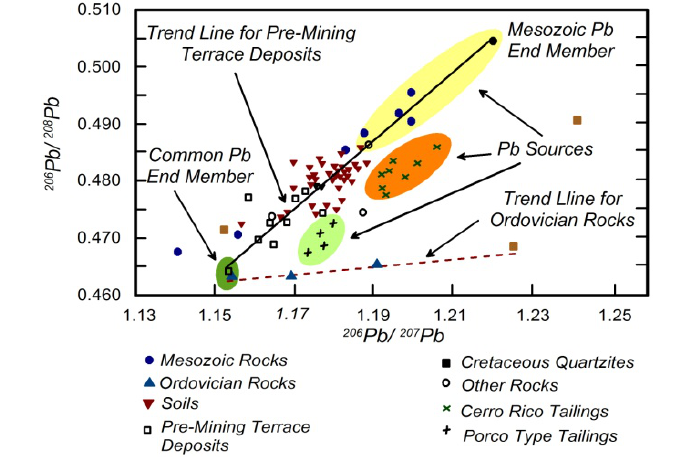
Figure 11. Soil samples from floodplain agricultural fields collected along the Rio Pilcomayo, Bolivia, exhibit Pb isotopic values that fall within the range established by four Pb sources, including Ordovician rocks, Mesozoic Rocks, and two types of ore deposits from Cerro Rico. As a result, mixing models could be used to assess the relative contribution of Pb from the underlying bedrock and mining operations (from Miller et al. [172]).